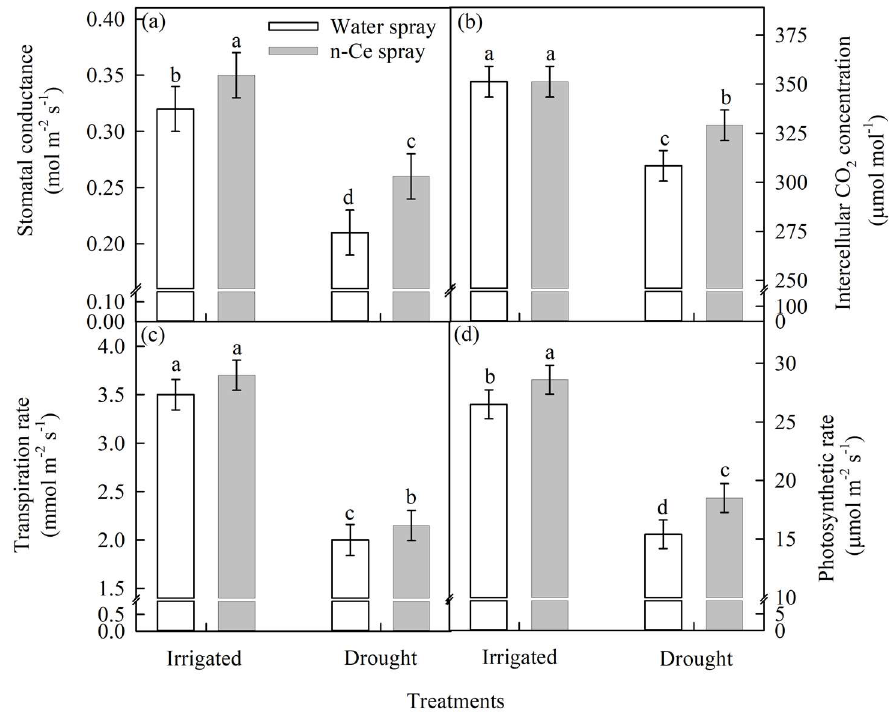
Figure 7. Effect of drought and foliar spray of nanoceria on ( a ) stomatal conductance (mol m −2 s −1 ), ( b ) intercellular CO 2 concentration (µmol mol −1 ), ( c ) transpiration rate (mmol m −2 s −1 ) and ( d ) photosynthetic rate (µmol m −2 s −1 ) in mungbean (pot culture experiment). Each value is the mean ± SD of 5 independent measurements. Means with different letters are significantly different at p ≤ 0.05.